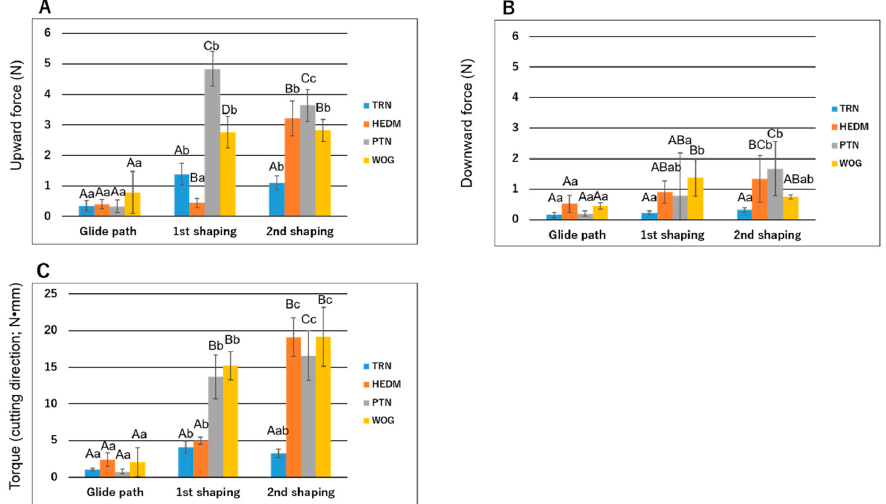
Figure 6. Maximum upward force ( A ), downward force ( B ), and torque in the cutting direction ( C ) generated during root canal instrumentation. Values are means and standard deviations (n = 10). Different uppercase letters in each instrumentation sequence in each panel indicate that the values are significantly different in intergroup comparisons ( p < 0.05; two-way ANOVA and Tukey test). Different lowercase letters in each panel indicate that the values are significantly different within the same instrument ( p < 0.05; two-way ANOVA and Tukey test).